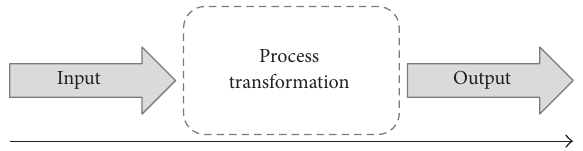
Figure 1: Transformation model in manufacturing and value cre-